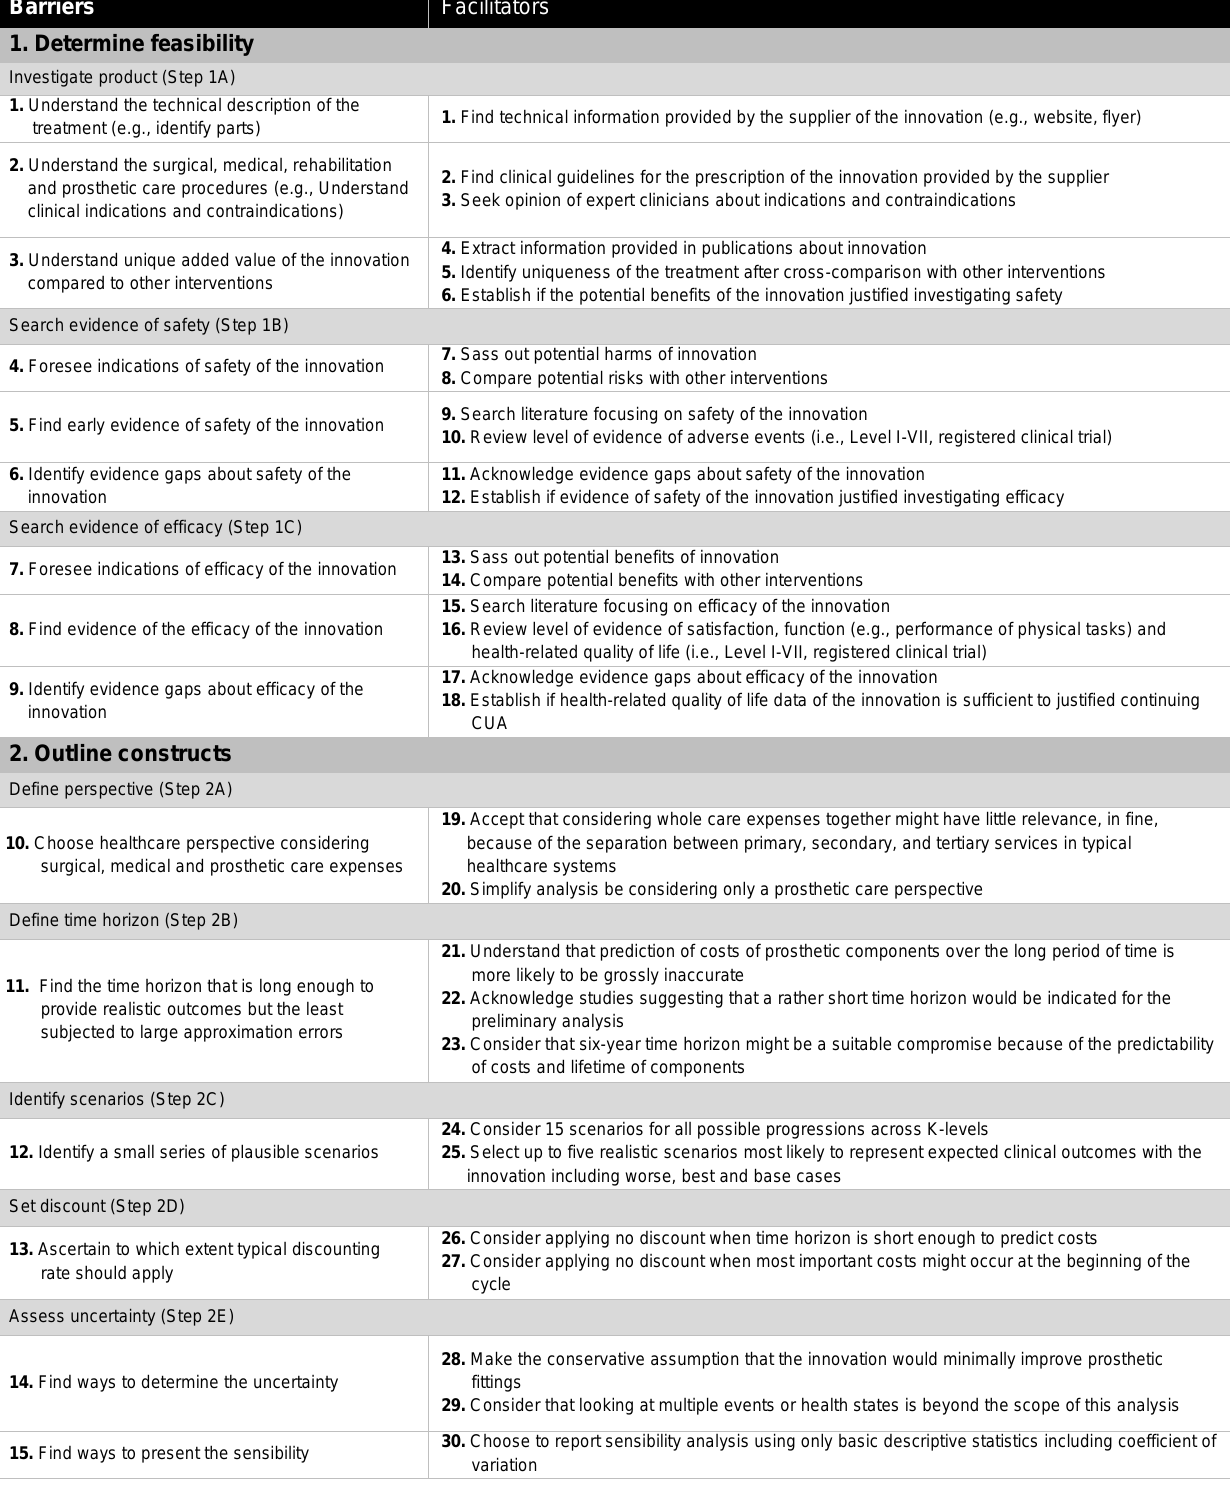
Table 2: Overview of manageable barriers and transferrable facilitators of basic framework of preliminary cost-utility analysis (CUA) comparing usual intervention (e.g., socket-based, socket-free using osseointegration) and a prosthetic care innovation susceptible to improve prosthetic fittings. ICUR: Incremental cost-utility ratio, K-level: Medicare Functional Classification Level, QALY: Quality-adjusted life-year, $: Australian